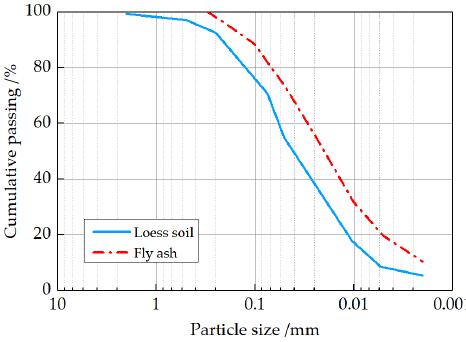
1760 Table 2. Chemical composition of fly ash. Composition